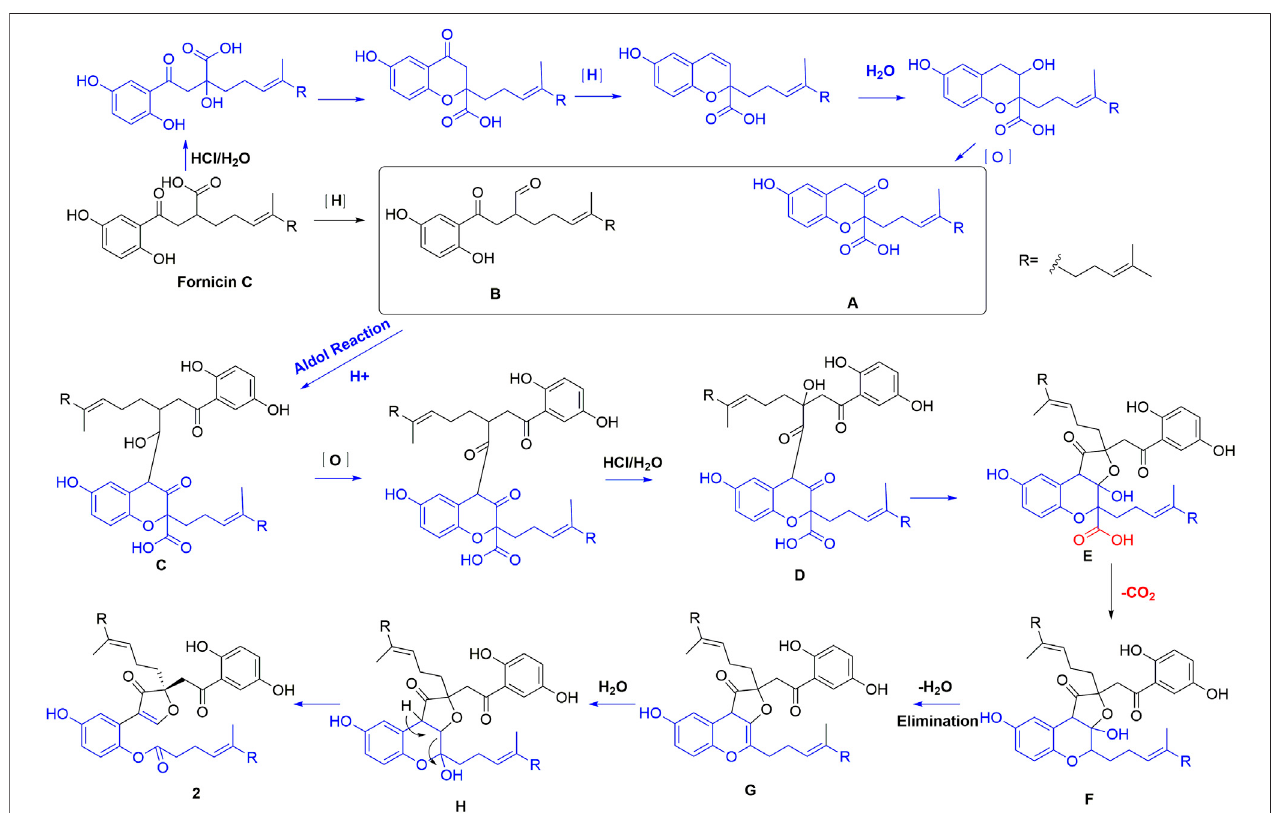
FIGURE 5 | Plausible pathway for the biogenesis of 2